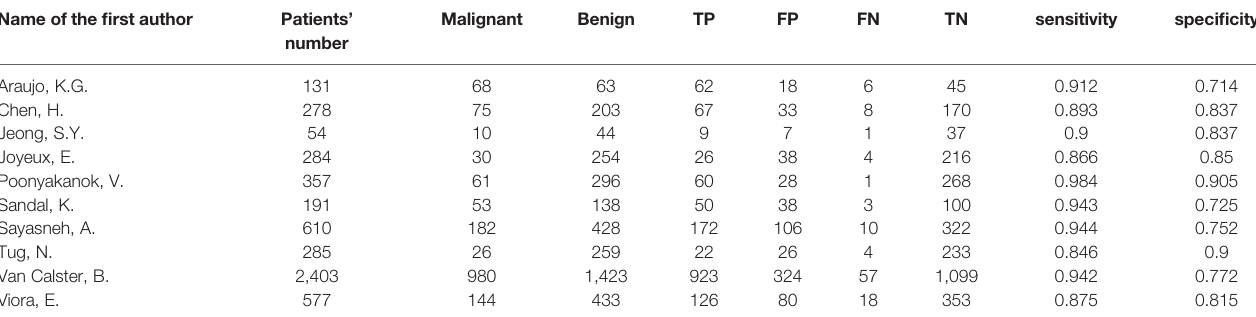
TABLE 2 | Parameter data extracted from eligible studies.